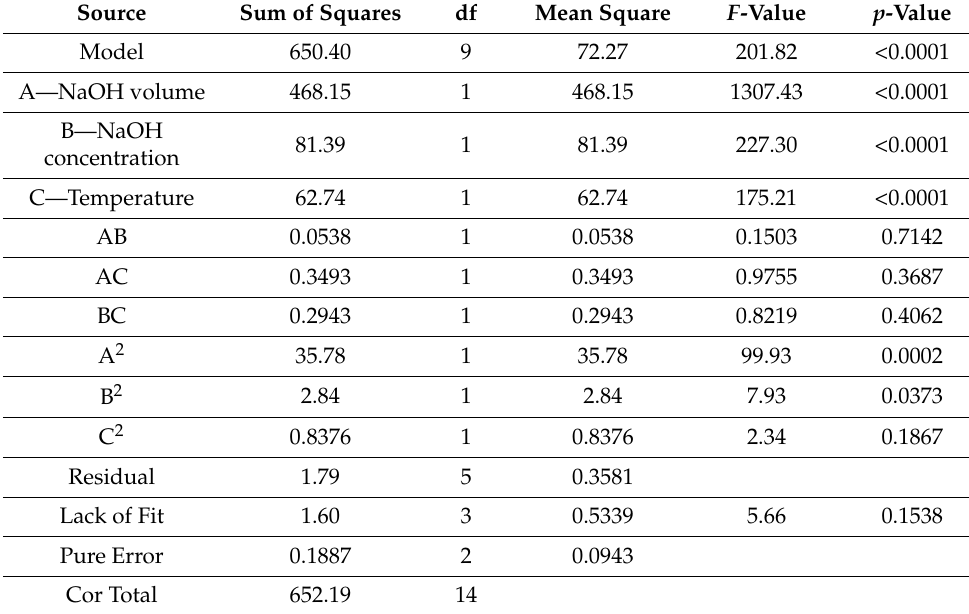
Table 2. ANOVA for Reactive Black 5 dye from the prepared